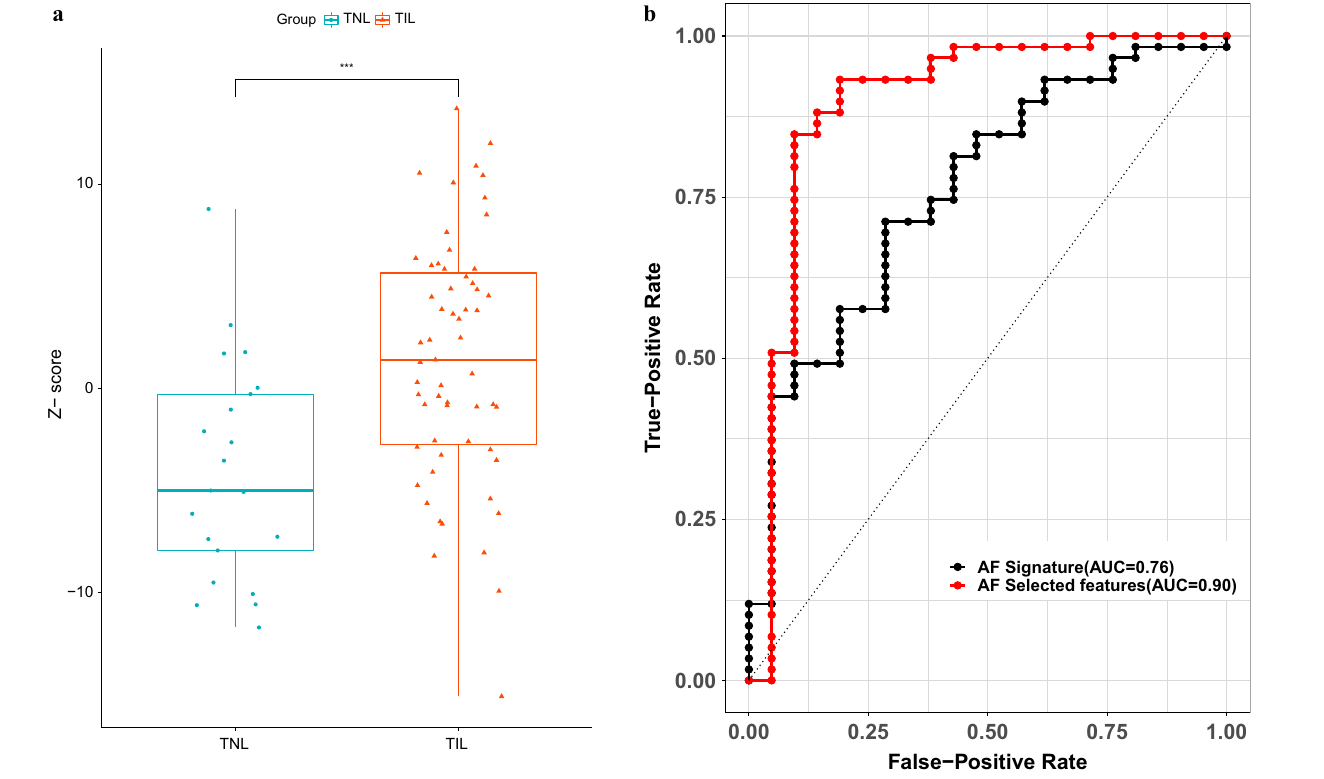
Figure 6. Changes in the amniotic fluid proteome are reflected in the maternal circulation and can distinguish term labor. ( a ) Boxplots showing changes in the amniotic fluid-derived labor signature in the maternal plasma proteomic profiles. The box plots were generated with the R package, ggpubr 163 . ( b ) Receiver operating characteristic curves for classifying maternal plasma samples into labor and no labor groups based on the plasma concentrations of proteins identified in the amniotic fluid. The black curve corresponds to the discrimination accuracy of the aggregated proteomic signature of the top 15 amniotic fluid proteins that were most increased in the TIL group compared to the TNL group. The red curve corresponds to the leave-one- out cross-validation (LOOCV)-based predictions of a random forest model trained with 10 proteins selected according to their importance from all amniotic fluid proteins increased in the TIL group compared to the TNL group. The ROC curves were plotted with the R package, pROC 164